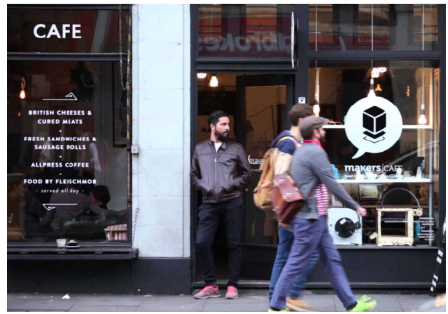
Figure 14. Makers CAFE (2014, London, UK).